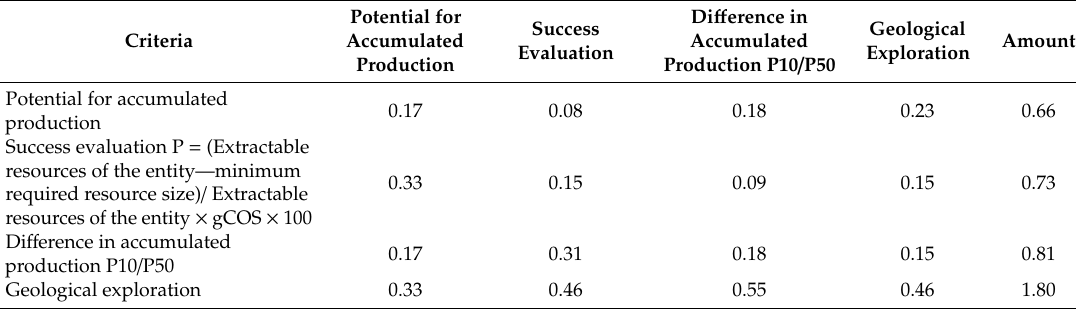
Table A9. Results of a normalized assessment of the relative importance of the geological sustainability criteria.